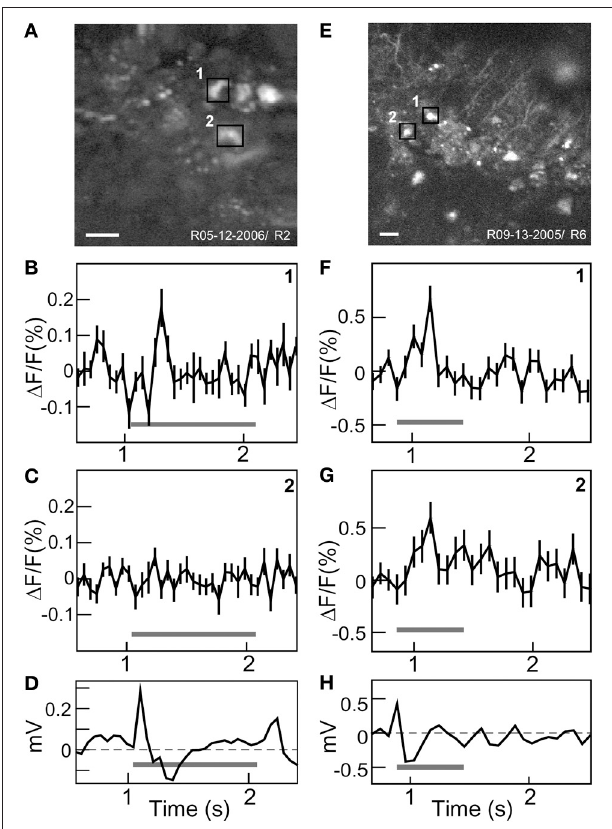
FIGURE 4 | In vivo functional two-photon scanning of Sindbis Flare transfected neurons in rat visual cortex. (A) High resolution (256 × 256) structural scan of first site with multiple labeled neurons with two ROIs (black squares) delimited. (B,C) Averaged fluorescence signal (mean ± standard error) from each ROI. Cell 1 responded to stimulus onset (B) , cell 2 did not respond (C) . Graphs (D) Visually evoked potentials from surface electrode. (E) High resolution (512 × 512) structural scan of second site showing labeled cell bodies and processes. Two neighboring cells are marked (black squares). (F,G) Averaged fluorescence signal (mean ± standard error) for cell 1 and 2 that both show significant responses. (H) Visually evoked potentials. Gray bars in (B–D, F–H) indicate ON stimulus period. Scale bars: 20 μ